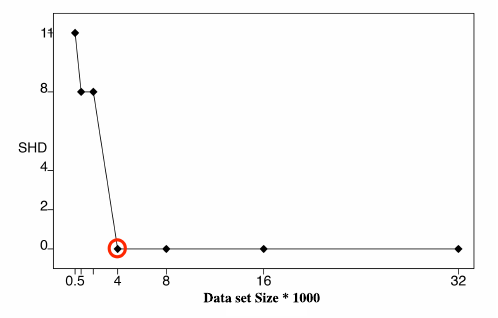
Figure 7. Structural Hamming distance (SHD) of different data set sizes using calculated ALS (Table 3) as reference value (red circle), Child Dataset.